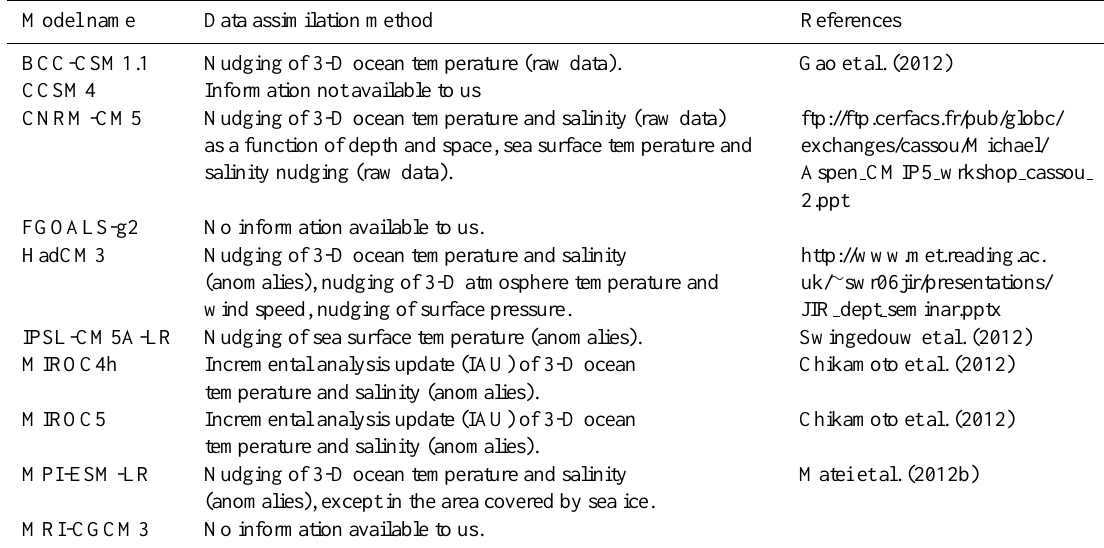
Table 3. Data assimilation methods used by the 10 models providing hindcast